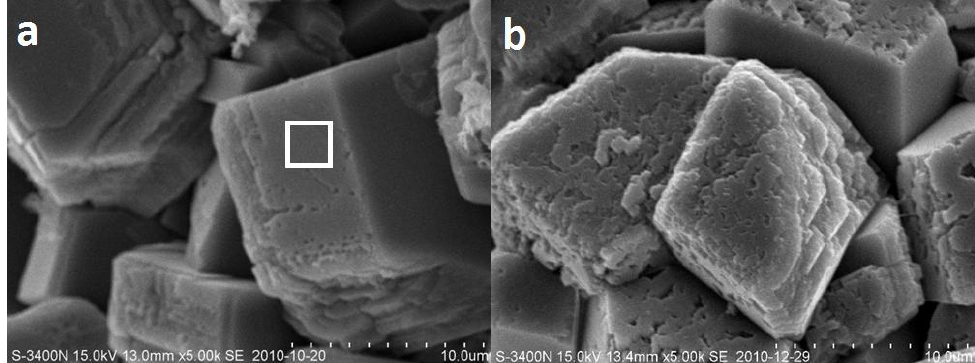
Figure 6. Scanning electron microscopy (SEM) images of calcium-rich crystals in concrete specimens at the immersion ages of ( a ) 0 and ( b ) 30